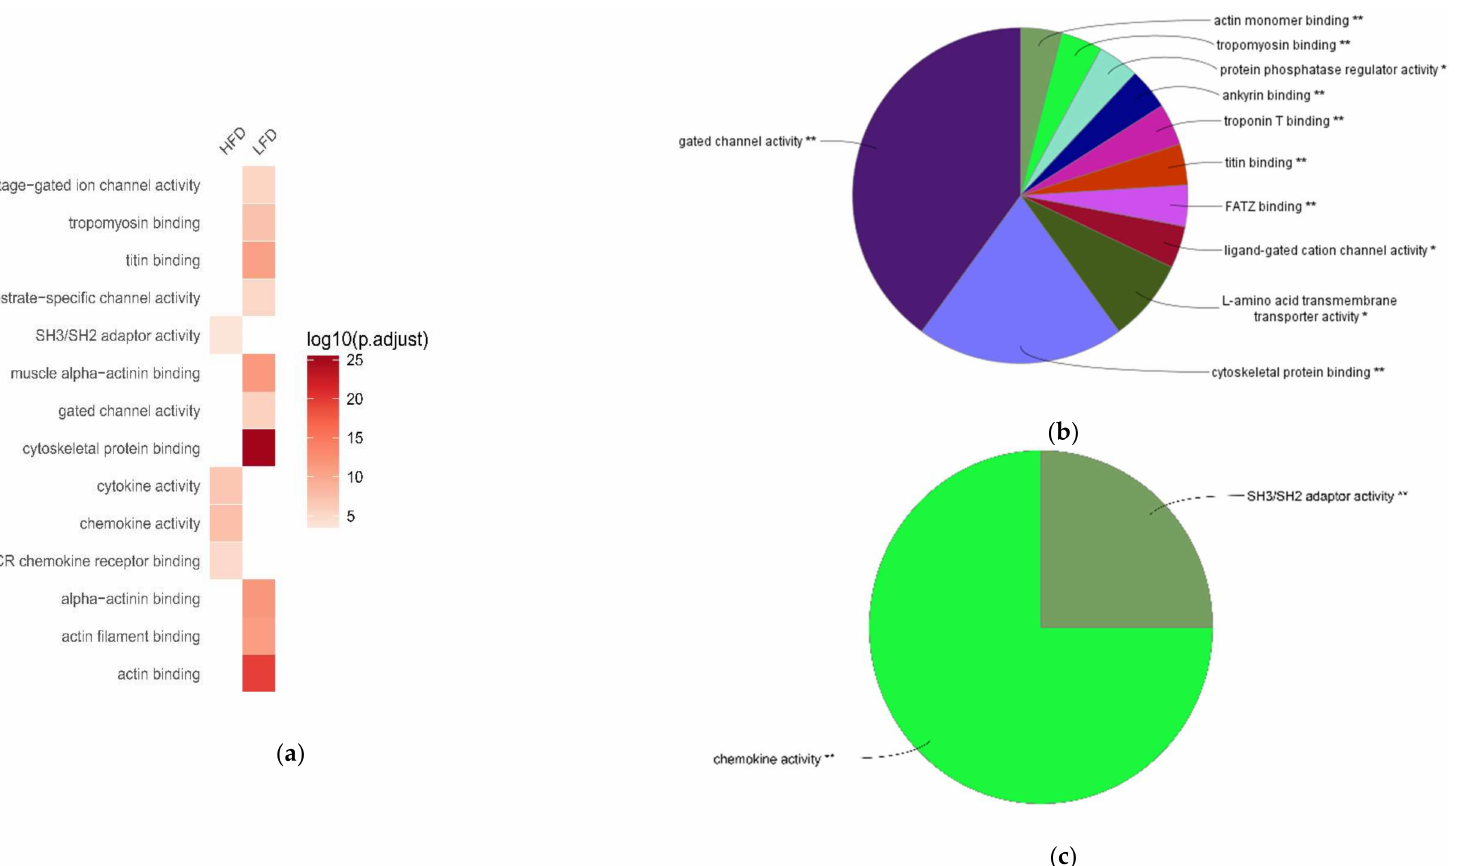
Figure 4. Comparing top Gene Ontology (GO) molecular function (MF) terms associated with high-fat diet (HFD)-responsive genes in brown adipose tissue (BAT). Enrichment analysis was performed using differentially expressed genes in BAT between HFD and low-fat diet (LFD) groups. ( a ) Heat-map showing top GO MF annotation terms in the BAT between HFD and LFD groups. ( b ) GO MF terms associated with downregulated genes in BAT of HFD-fed obese mice. ( c ) GO MF terms associated with upregulated genes in BAT of HFD-fed obese